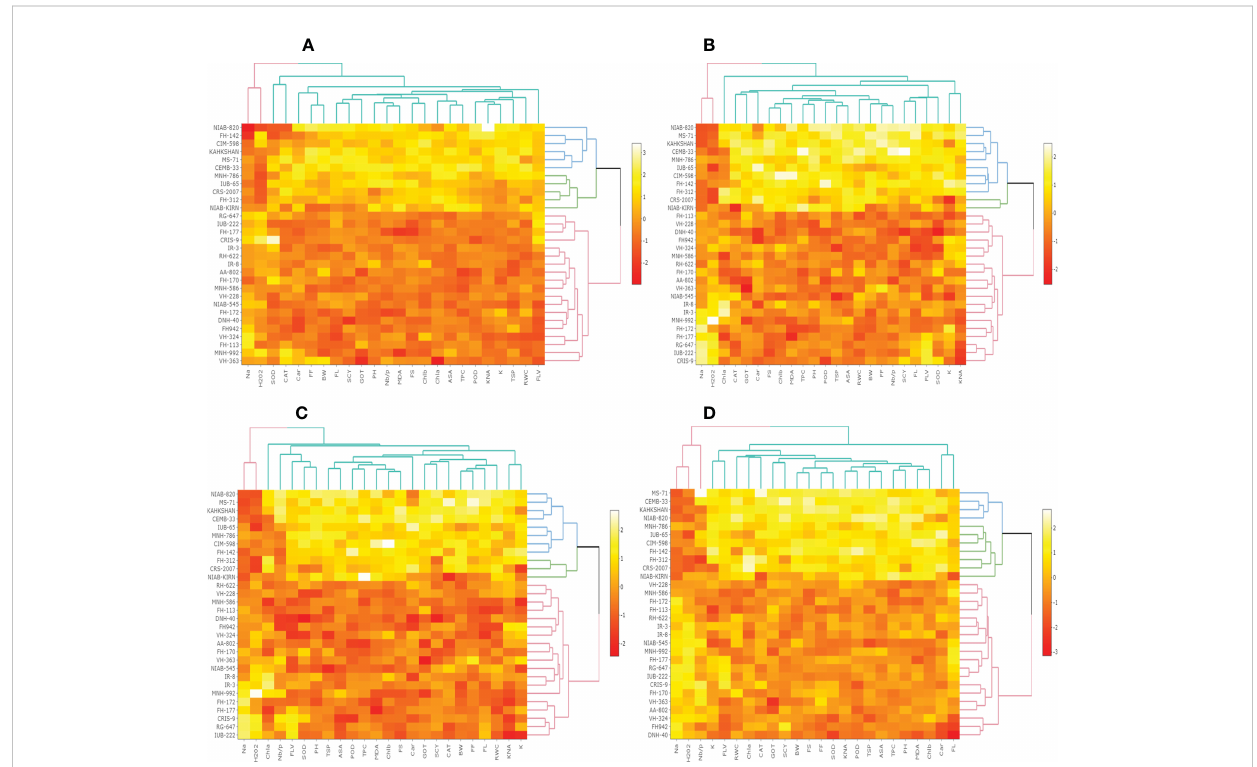
FIGURE 2 Second year PCA-Biplot of various agro-physiological, biochemical, and fi ber quality traits of 30 cotton genotypes (A) control, (B) drought stress (D) , (C) heat stress (H), and (D) drought + heat stress (DH). ASA, ascorbic acid; BW, boll weight; CAR, carotenoids; CAT, catalase; Chla, Chlorophyll a; Chlb, Chlorophyll b; FF, fi ber fi neness; FL, fi ber length; FLV, fl avonoids; FS, fi ber strength; GOT, ginning out turn percentage; H202, Hydrogen peroxide; K+, potassium content; K+/Na+, the potassium over sodium ratio; MDA, malondialdehyde; Na+, the sodium contents; NBP, Number of bolls per plant; PH, plant height; POD, peroxidase; RWC, Relative water content; SCY, seed cotton yield; SOD, superoxide dismutase; TPC, total phenolic content; TSP, total soluble